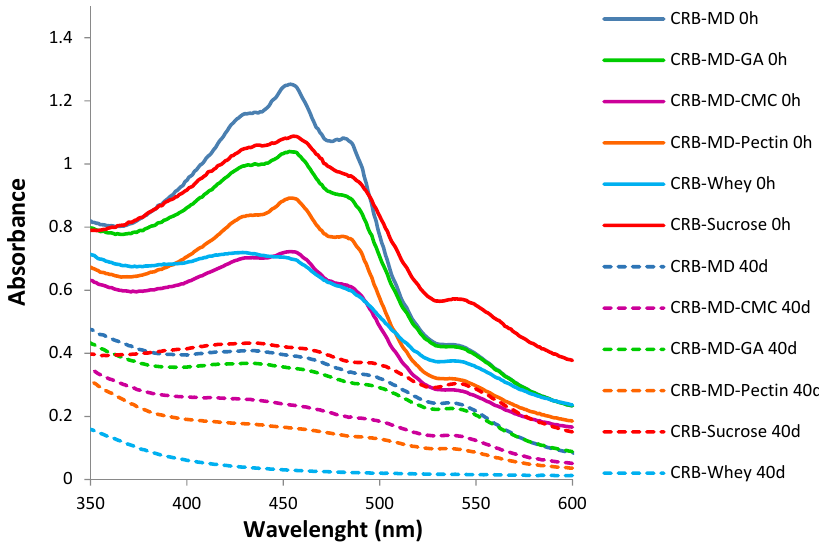
Figure 8. Visible spectra of pure CRB microcapsules aqueous solution/dispersions before and after physical stability tests. Stability tests conducted at 0.3 mg/mL for all systems. The solid lines show the characteristic bands for the CRB systems at 0 h, whereas the dashed lines show the decrease in the absorbance after 40 days. Notice the lack of absorbance for CRB-Whey (dashed line) after 40 days. Figure 7 shows the comparison of UV spectra for PB-MD and PB-MD-GA dispersions at day 0